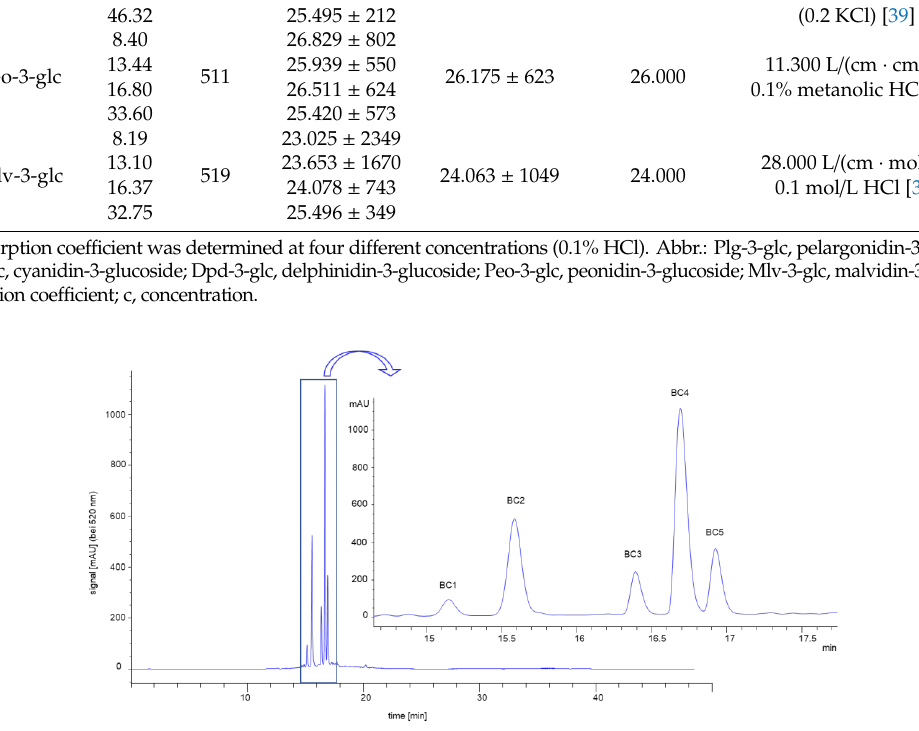
Figure A1. Chromatogram and respective structures of the complex black carrot anthocyanin extract (BC-ACY) at 520 nm. Abbr.: BC 1, Cyd-3-gal-xyl-glc; BC 2, Cyd-3-gal-xyl; BC 3, Cyd-3-gal-xyl-glc(sin); BC 4, Cyd-3-gal-xyl-glc(fer); BC 5, Cyd-3-gal-xyl-glc(cum). Table A2. Major anthocyanin structures characterized by mass spectrometry in the complex anthocyanin extract of black carrot.